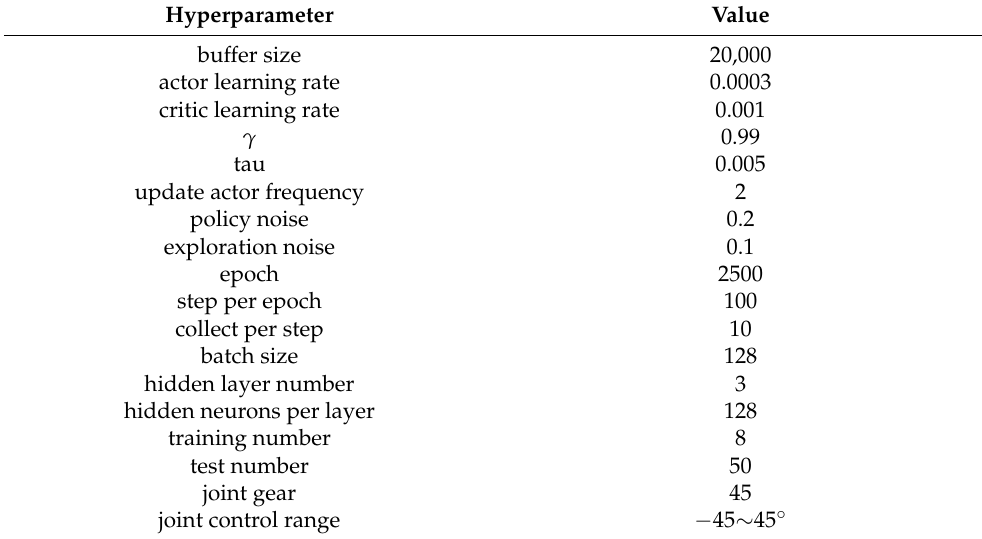
Table 1. Hyperparameter of the training